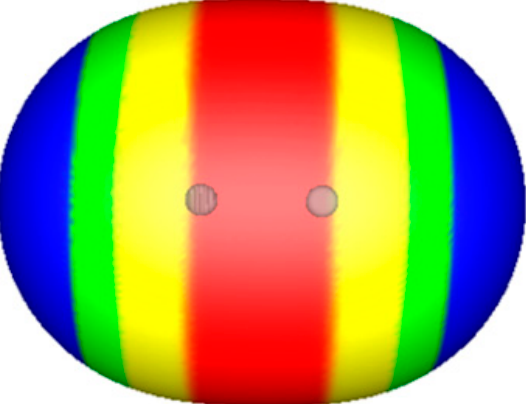
Figure 1. Computed electrostatic potential on 0.001 au molecular surface of N 2 . Gray circles indicate positions of nuclei. Color ranges in kcal/mol: red, more positive than 6; yellow, between 6 and 3; green, between 3 and 0; blue, negative.